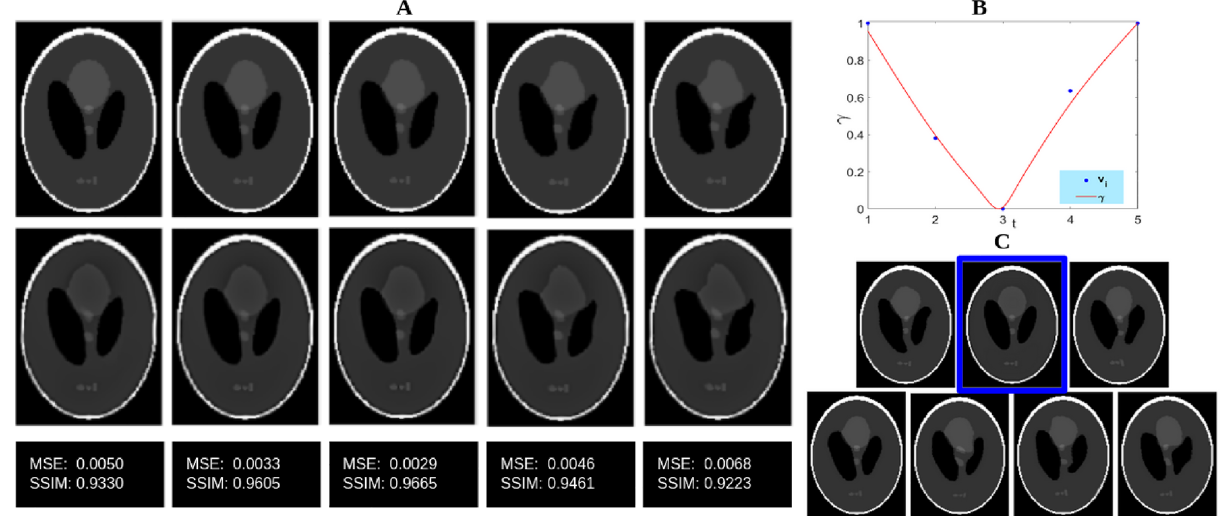
Figure 11. Aging model for a simulated longitudinal dataset. ( A ) First row: Deformed images with known transformation and second row: images generated with the proposed model, for the same time points (as in the first row) and last row: the MSE and SSIM of first and second rows; ( B ) The γ curve of our aging model and ( C ) some sample images used in S